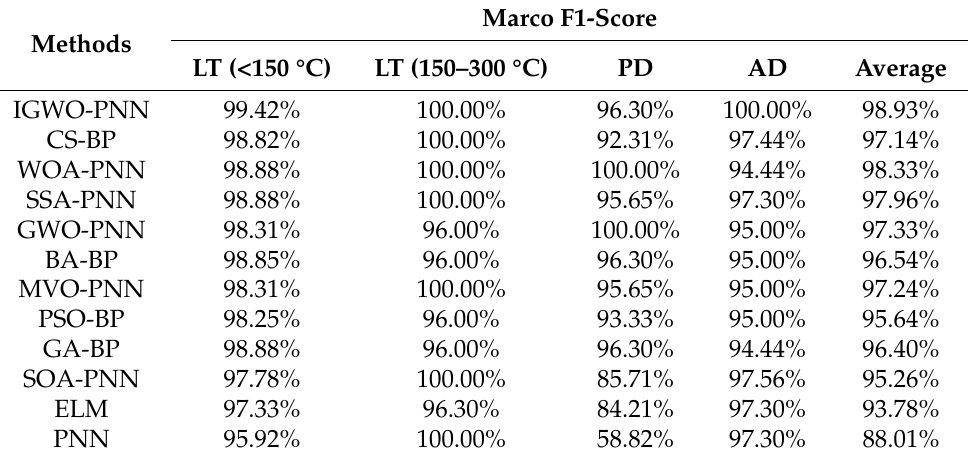
Table 8. Marco FI-score of different methods.